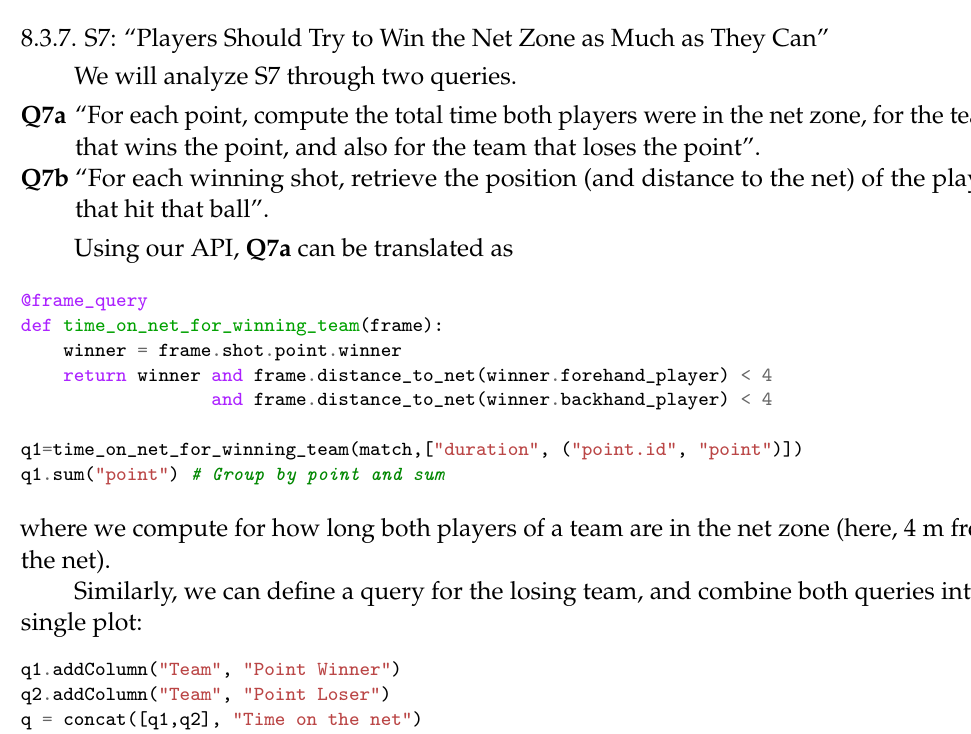
Figure 16. Motion of the four players a after a serve: 0.5, 1.0, 1.5 and 2.0 s. Please note that court-space players’ positions in our test datasets were approximate, with a larger error for players in the top side of the